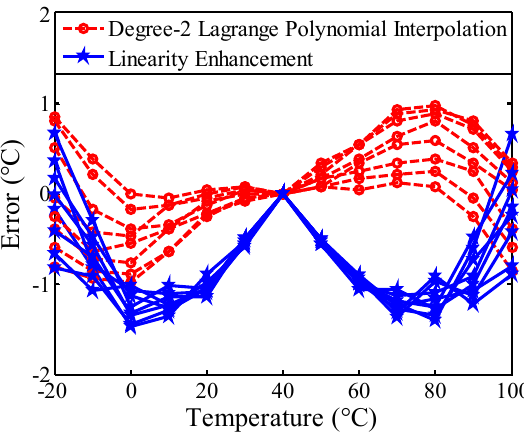
Figure 10. Estimated inaccuracies of the two techniques considering process variations of eight sensors.